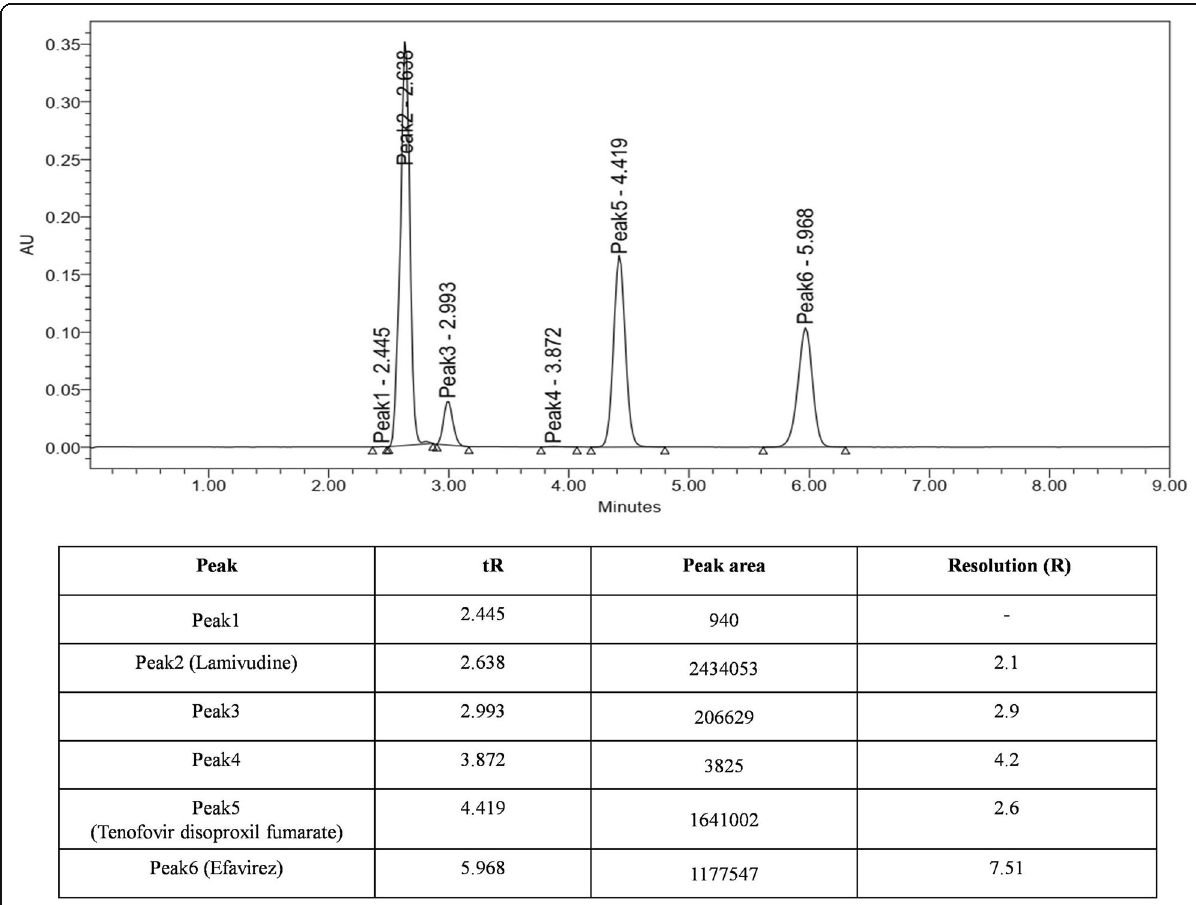
Fig. 4 Chromatogram of acid